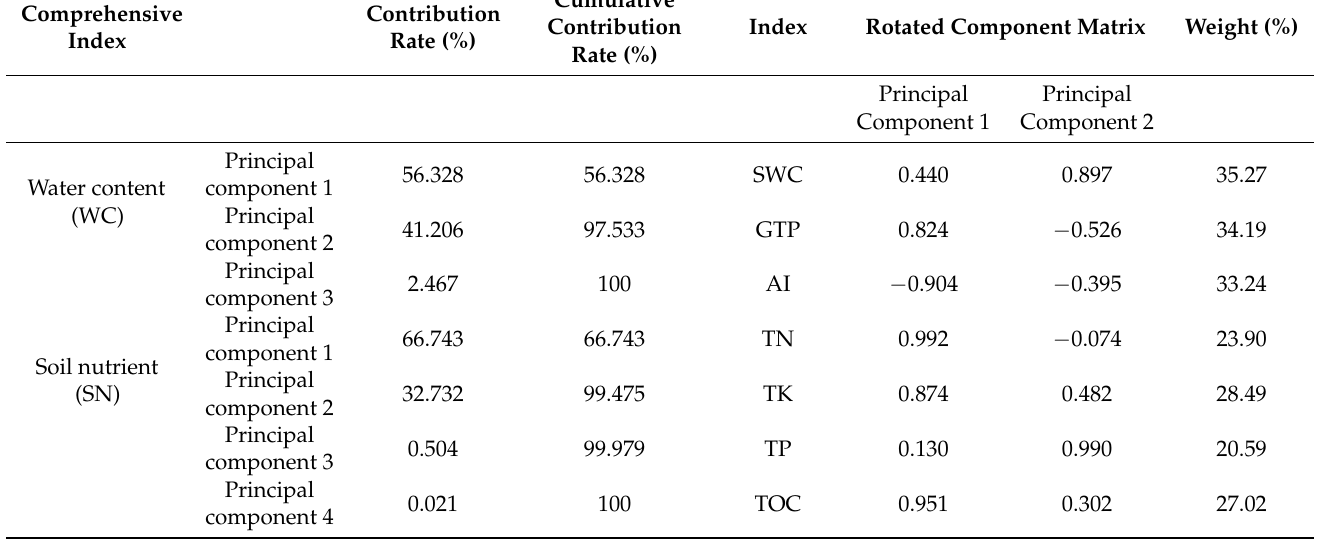
Table 2. The contribution of each indicator in principal component analysis of water content (WC) and soil nutrient